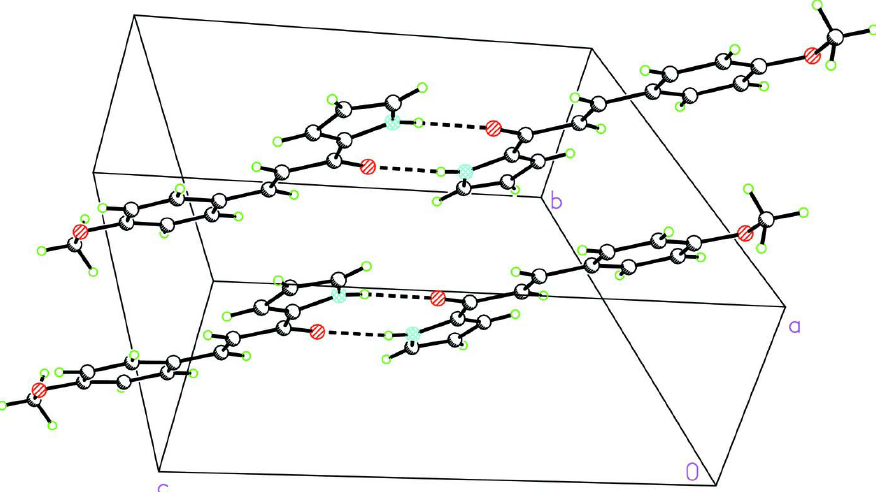
Figure 1 The molecular structure of the title compound with displacement ellipsoids drawn at the 30% probability level and H atoms as spheres of arbitrary radius.